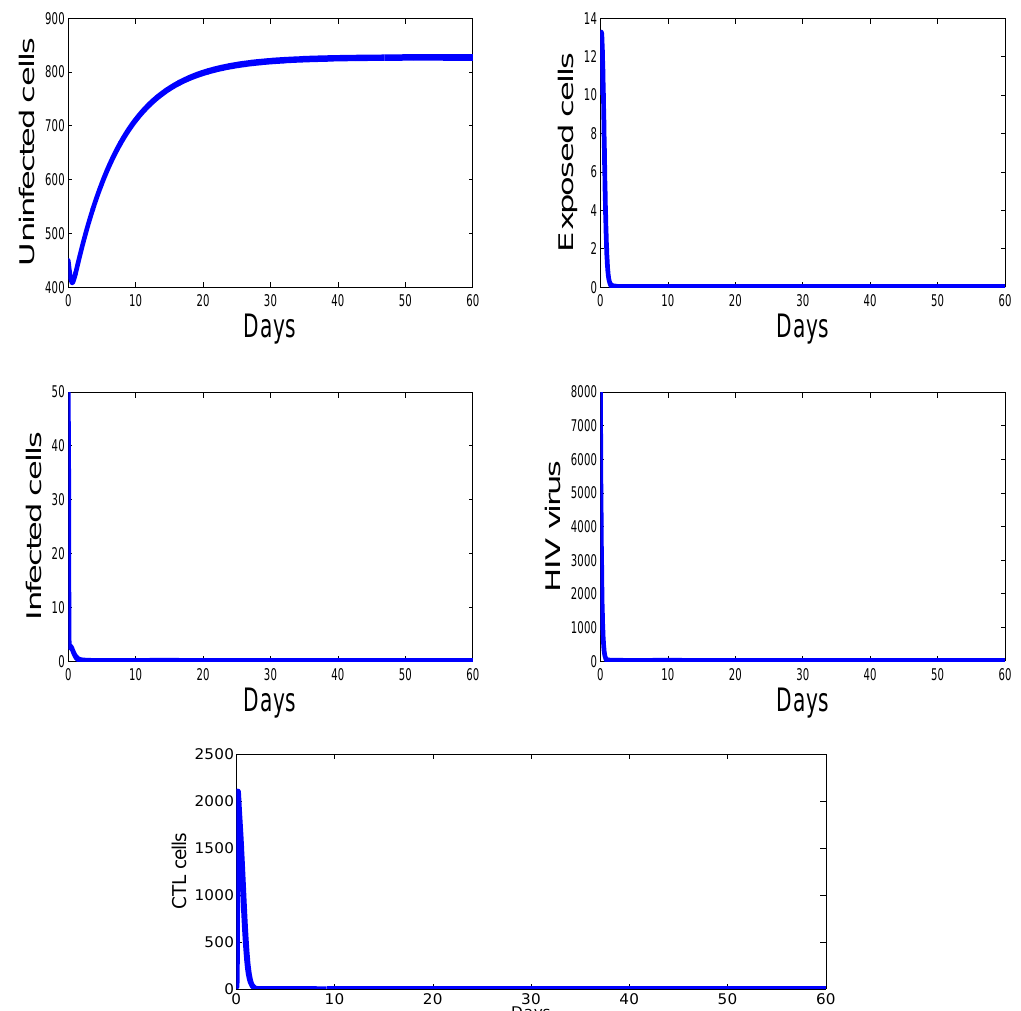
Figure 2. The behavior of the infection dynamics for λ = 10, d 1 = 0.0139, k 1 = 0.04, d 2 = 0.0495, k 2 = 1.1, d 3 = 0.5776, a = 2, d 4 = 0.6, p = 0.0024, c = 0.15, b = 0.5. For the parameters used in this figure, the basic reproduction number is R 0 = 0.2209 < 1. Solutions of the system converge to the disease-free equilibrium point E f = ( 827.22,0,0,0,0 )